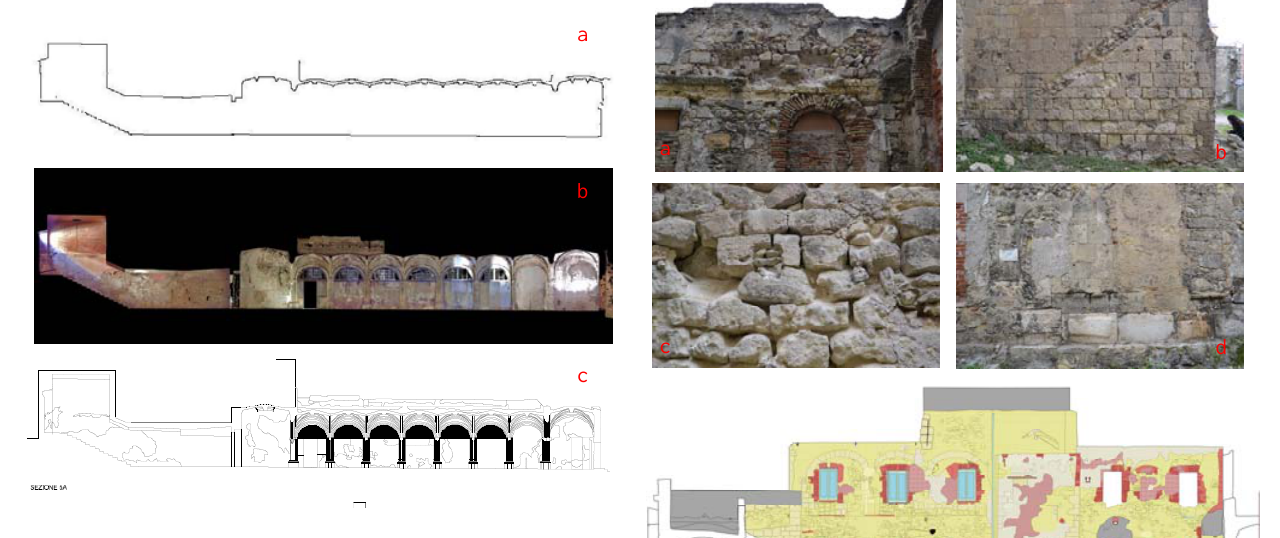
Figure 7: a) A vertical section generated by the software; b) an orthophoto generated by the software; c) a vertical section restituted by an operator with the support of the orthophoto